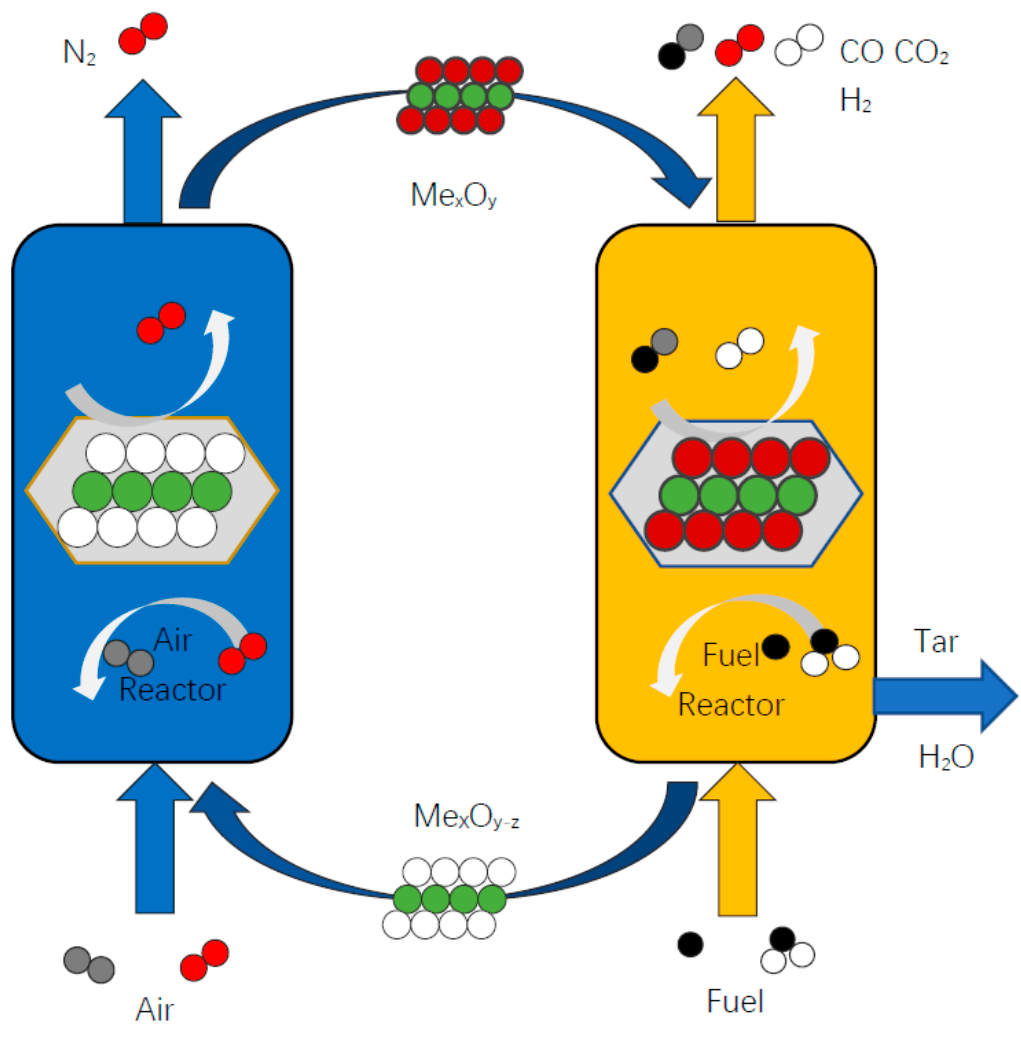
Figure 1. Schematic diagram of the CLG principle.